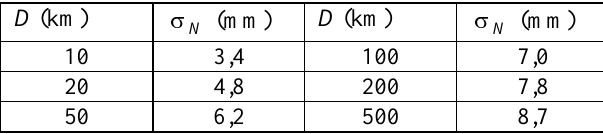
Table 1. The aliasing error in Finland as a function of geoid support point separation